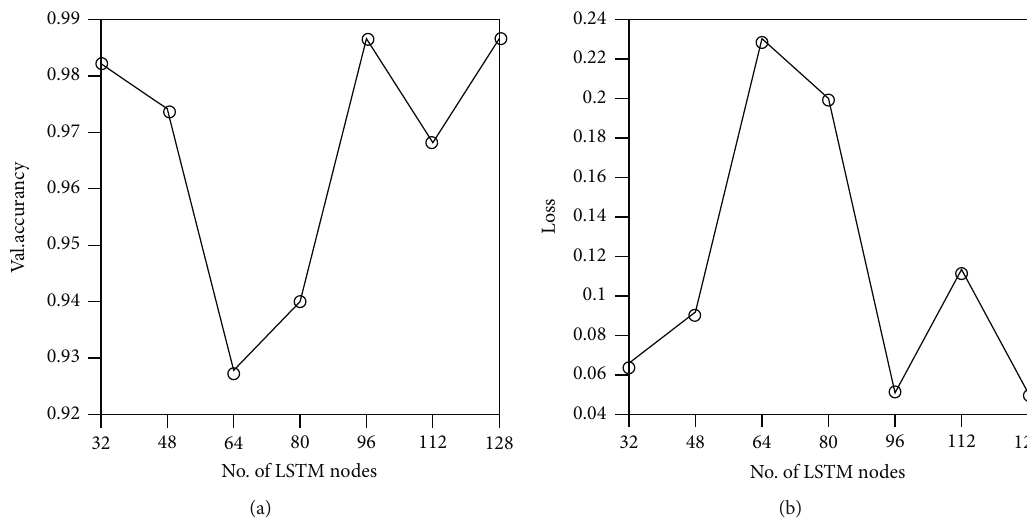
Figure 7: Val. accuracy and training loss of di ff erent Nos. of CNN fi lters: (a) fi nal ( epoch = 2000 ) accuracy on the validation set; (b) loss at the end of training ( epoch = 2000 ). Each data point is an average value of 30